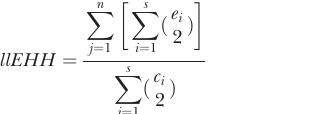
Figure S1. F ST and Heterozygosity for SNPs within 100 kbp of CCR5 Compared to 100-kbp Sliding Windows for HapMap Release 16 for European-Americans Figure S2. The DAF Distribution of CCR5 Compared to 100-kbp Sliding Windows for HapMap Release 16 for European-Americans Found at DOI: 10.1371/journal.pbio.0030378.sg002 (62 KB